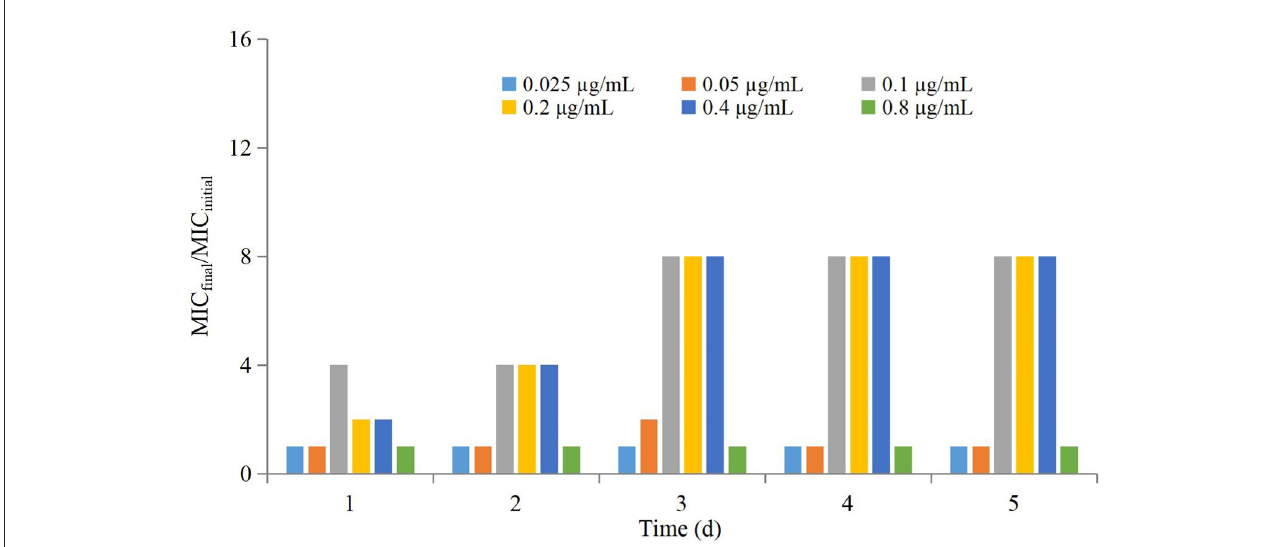
FIGURE3 Values of MIC final /MIC initial after drug administration for a different number of times.